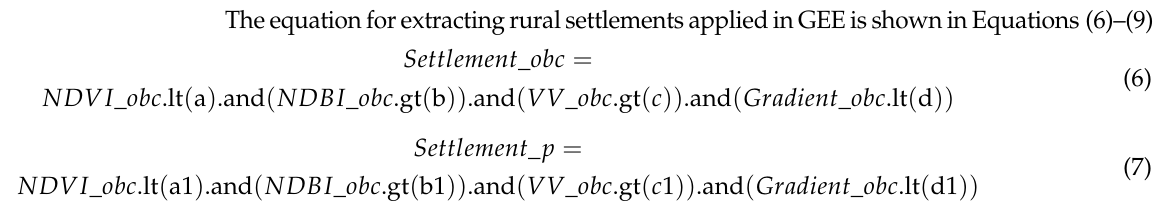
Figure 7. Example of determination of pixel-and object-based thresholds for NDVI for the rural settlement.